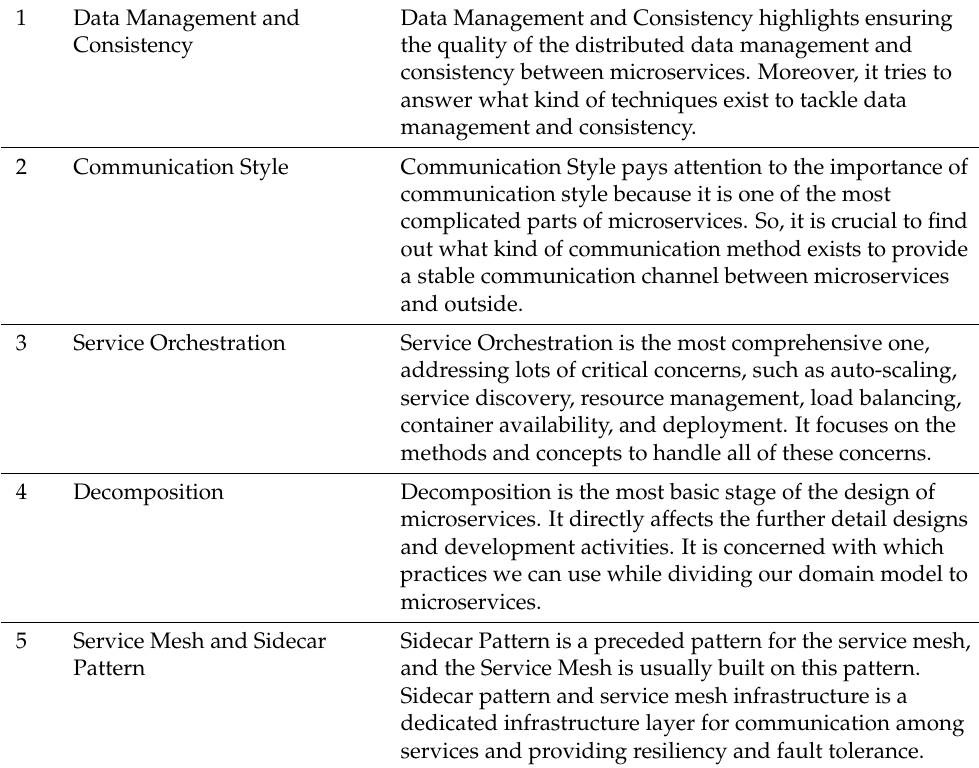
Figure 3. Top-level feature diagram of MSA. Table 1. Description of the top-level features of the feature diagram for MSA.